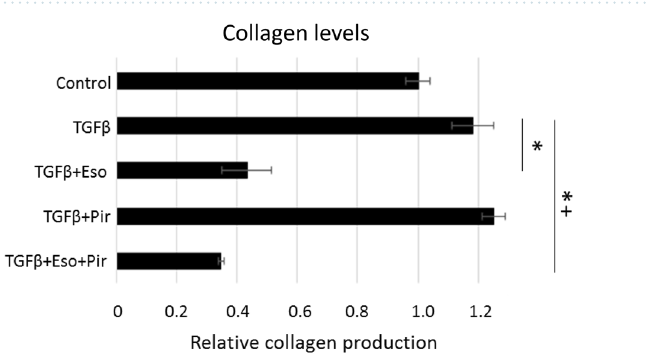
Figure 3. The effect of esomeprazole (Eso), pirfenidone (Pir) or the combination on the contractility of IPF lung fibroblasts using cell contraction assay. The cells were treated with TGFβ (10 ng/mL) for 24 or 48 h in the absence or presence of esomeprazole (100 µM), pirfenidone (1 mM) or esomeprazole (100 µM) and pirfenidone (1 mM) combination. The contractility of cells embedded in collagen gels was followed over time and the area of the gel was calculated for comparison. Data represents three independent experiments. *p < 0.05 vs TGFβ only control and + p < 0.05 vs pirfenidone alone group.